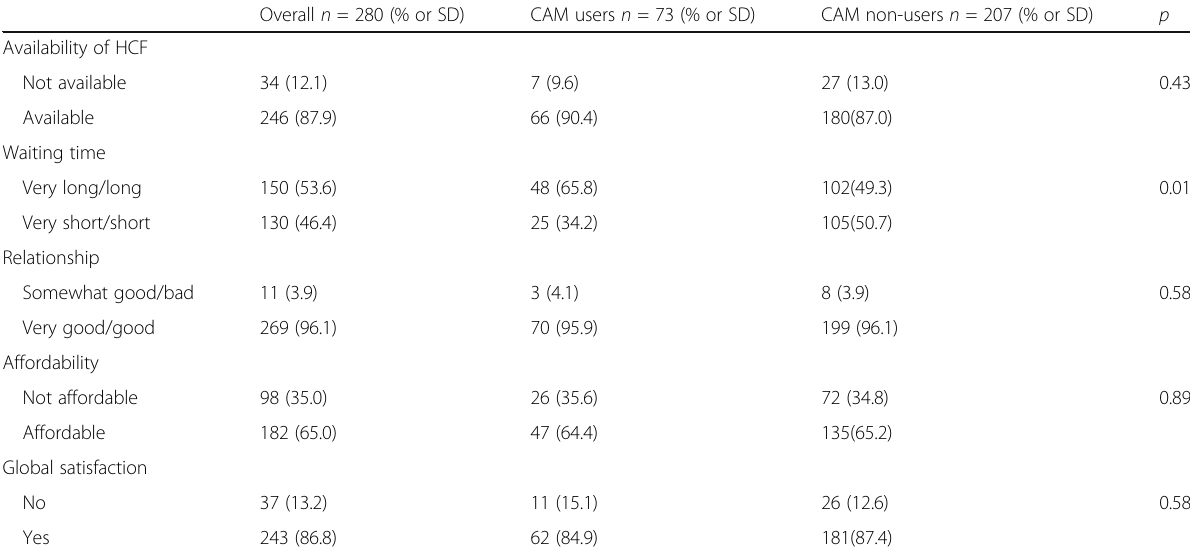
Table 7 Healthcare system factors